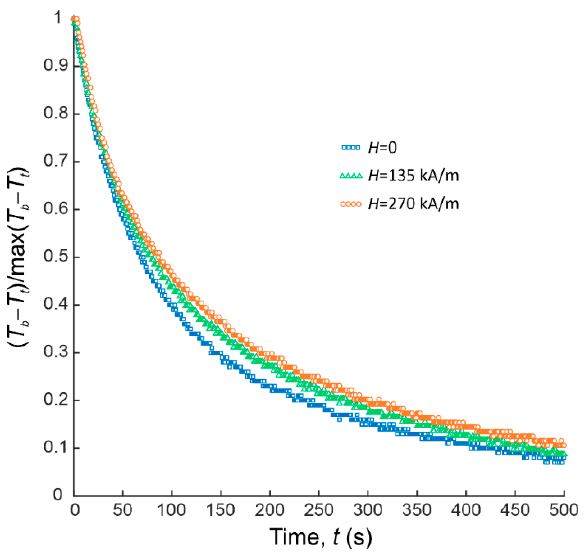
Figure 8. The time dependence of the normalized temperature difference between the bottom and top plates of the cell during cooling process. The results obtained in the absence and under the influence of a magnetic field are shown.